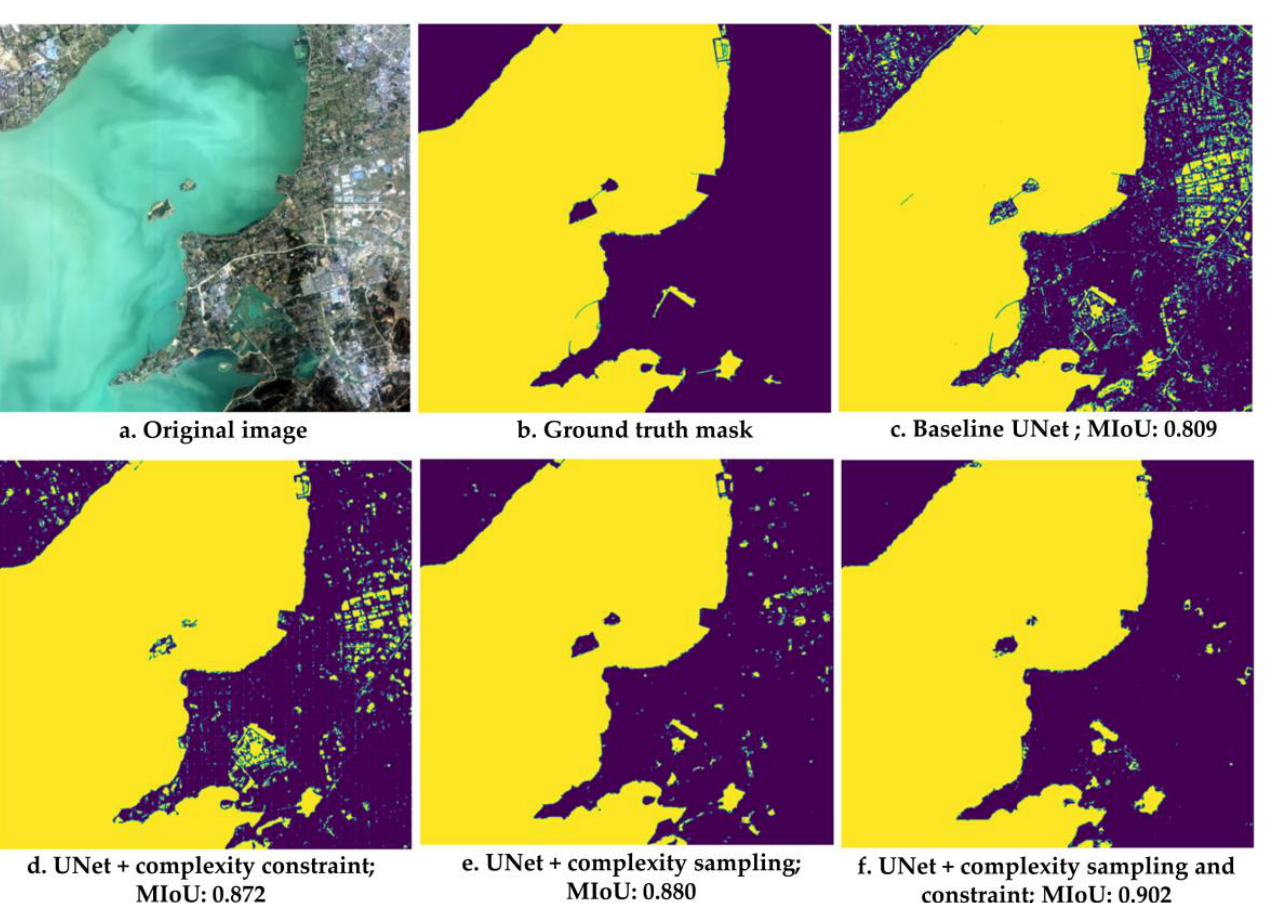
Figure 12. Comparison between meadow segmentation results of baseline UNet, UNets with com- plexity-informed constraint / sampling, and UNet with both. ( a ) shows the RGB images depicting true colors; ( b–f ) display yellow masks representing the meadow feature for ground truth ( b ) or predictions ( c - f ).